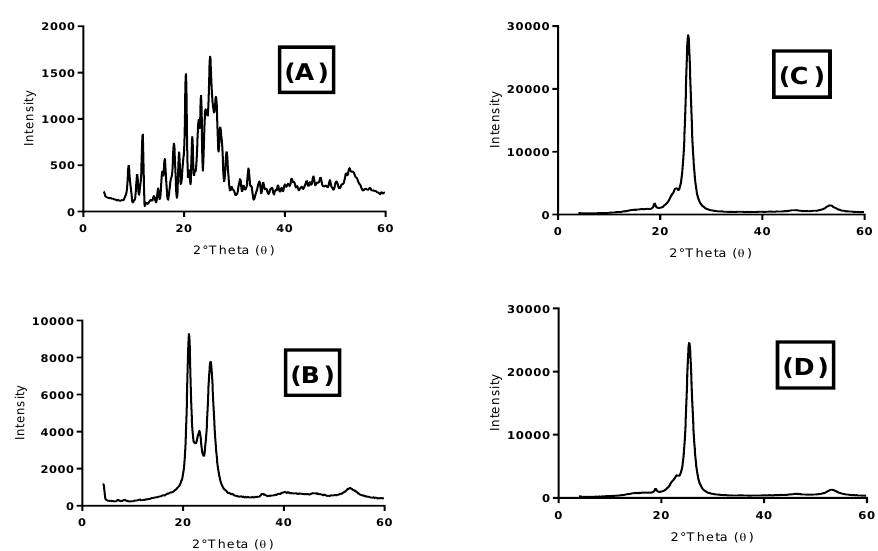
Figure 6. X-ray diffraction patterns of ( A ) Temazepam powder, ( B ) Compritol ® 888 ATO, ( C ) Plain NLC-1 freeze-dried powder, and ( D ) Temazepam NLC-1 freeze-dried powder.